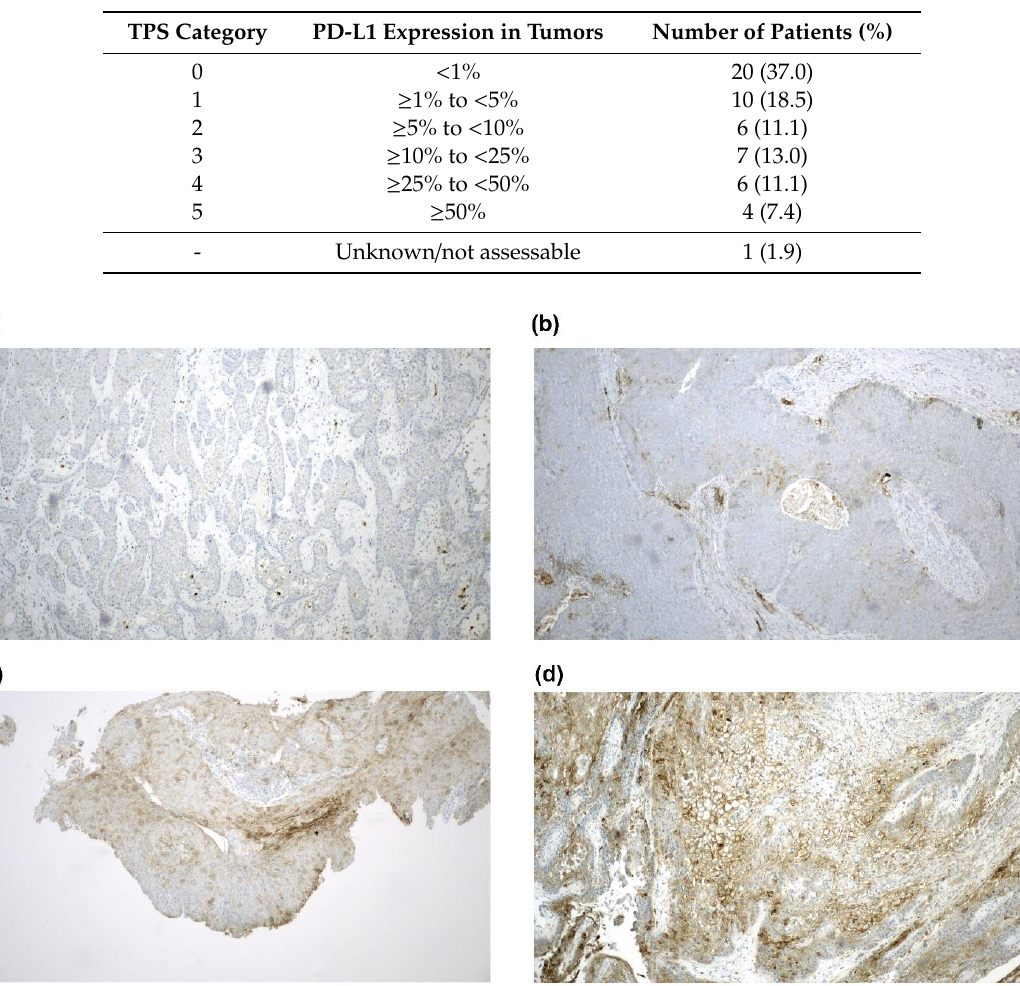
Table 3. Distribution of HPV subtypes and corresponding PD-L1 expression status.